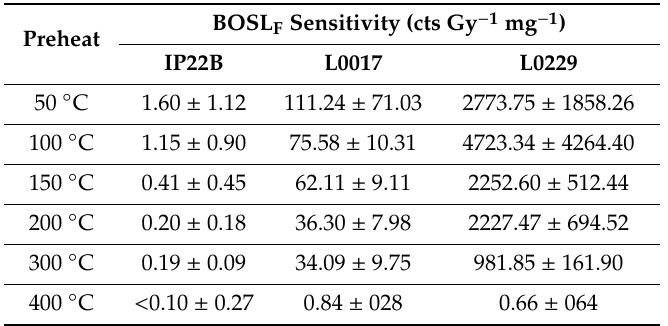
Table 6. Quartz BOSL F sensitivity measured using di ff erent preheat temperatures (step 5 of the protocol in Table 2). Sensitivity values correspond to the average of three aliquots ( ± standard deviation). Sample type is described in Table 1.